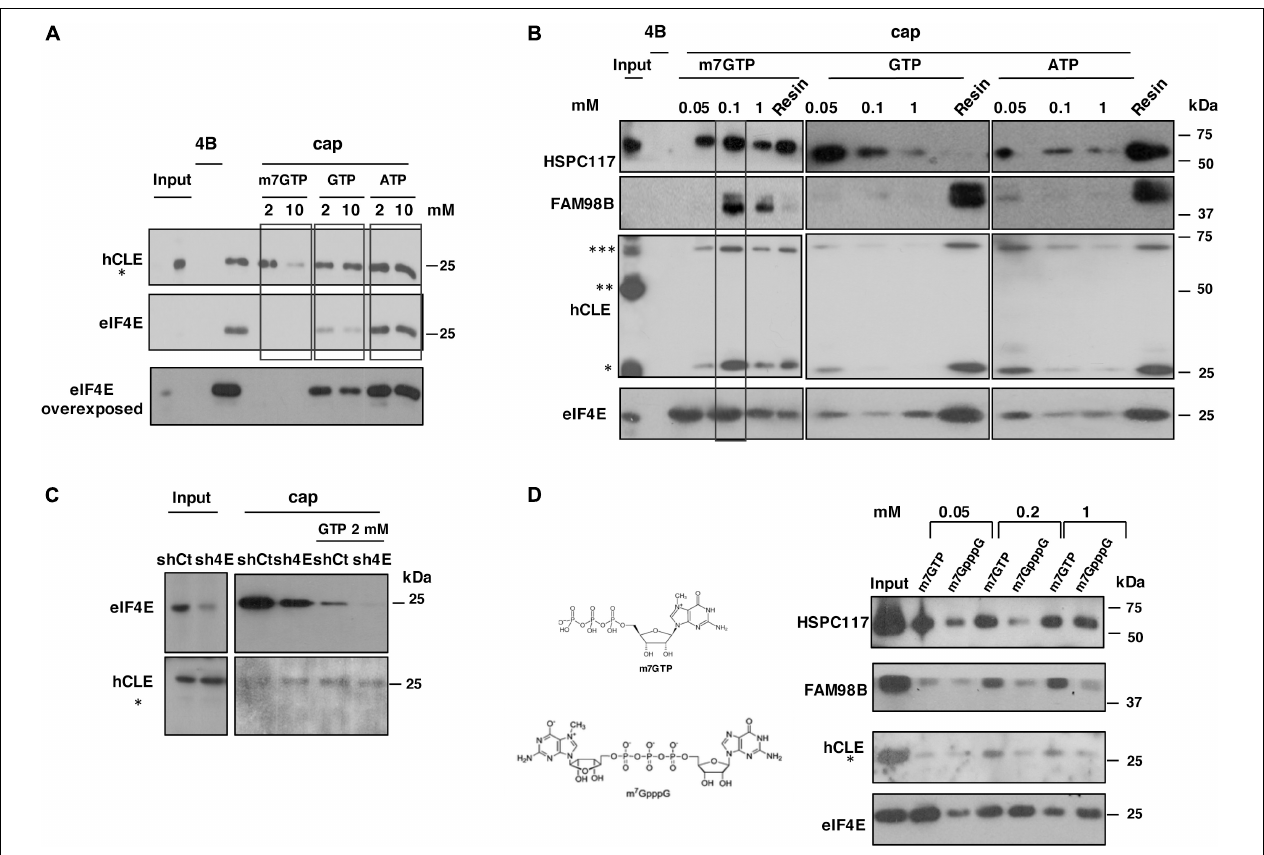
FIGURE 3 | Biochemical properties of the hCLE-complex cap-binding activity. (A) Total extracts of HEK293T cells were incubated with cap analog (cap) or control resins (4B) in the presence of different concentrations of m 7 GTP, GTP or ATP (2 and 10 mM). Retained hCLE and eIF4E proteins in the corresponding resins after extensive washes were analyzed by Western blot. The experiments were repeated three times. (B) Total extracts of HEK293T cells were incubated with cap analog and control resins. After washing, protein was eluted sequentially with increasing concentrations of m 7 GTP, GTP or ATP (0.05, 0.1, and 1 mM). Eluted and resin-bound proteins were analyzed by Western blot. The experiments were repeated three times. (C) HEK293T cells were transfected with a control silencing plasmid (shCt) or with a plasmid specific for eIF4E silencing (sh4E). Total extracts were incubated with cap-analog resin alone or in the presence of GTP 2 µ M and after washing, the retained proteins analyzed by SDS-gels and Western blots. (D) Total extracts of HEK293T cells were incubated with cap analog resins as indicated in part B. Protein was eluted sequentially with increasing concentrations of m7GTP, or m 7 GpppG (0.05, 0.2, and 1 mM). Eluted proteins were analyzed by Western blot and quantitated using ImageJ application (bottom). The experiments were repeated two